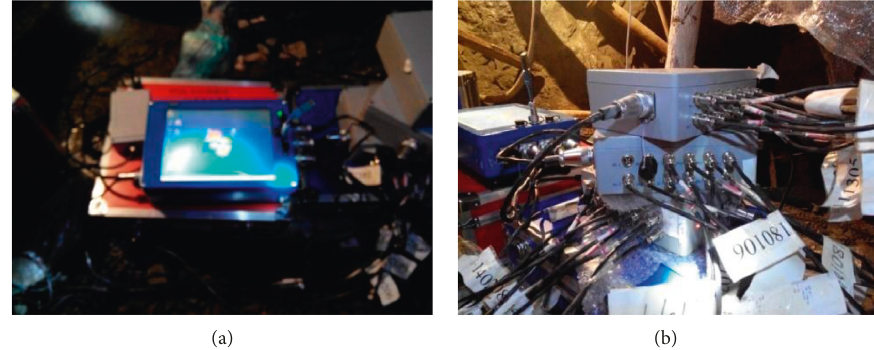
Figure 1: Site monitoring equipment layout. (a) Data recorder. (b) Data